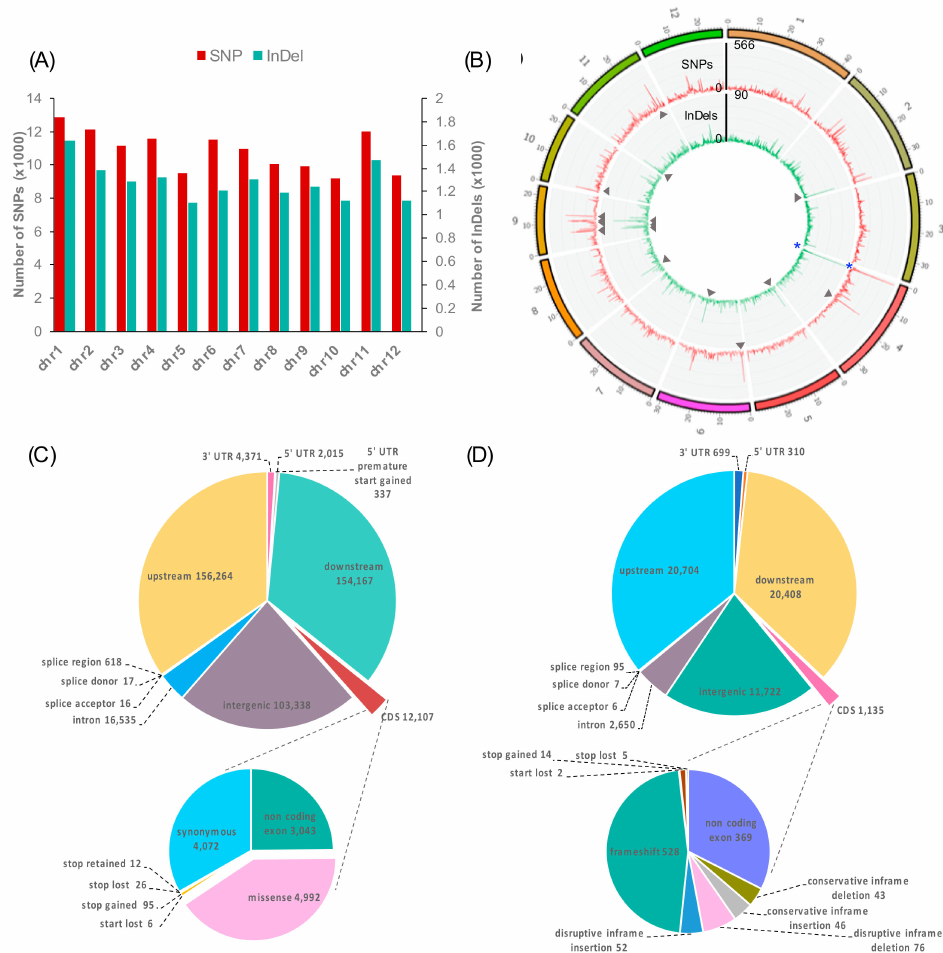
Figure 4. Distribution ( A ) and density ( B ) of variants across rice chromosomes identified in MY / KK–JK / NN. Variant densities were computed within a 100-kb window. The outside and inside of the Circos diagram represent SNP density (red line) and InDel density (green), respectively. The grey arrowheads indicate variant hotspots. MY: Ma Yom, KK: Khitom Khao, JK: Jao Khao, NN: Nahng Nuan. Structural annotation of variants identified in MY / KK-JK / NN. Pie charts represent variant annotations and numbers of MY / KK-JK / NN SNPs ( C ) and InDels ( D